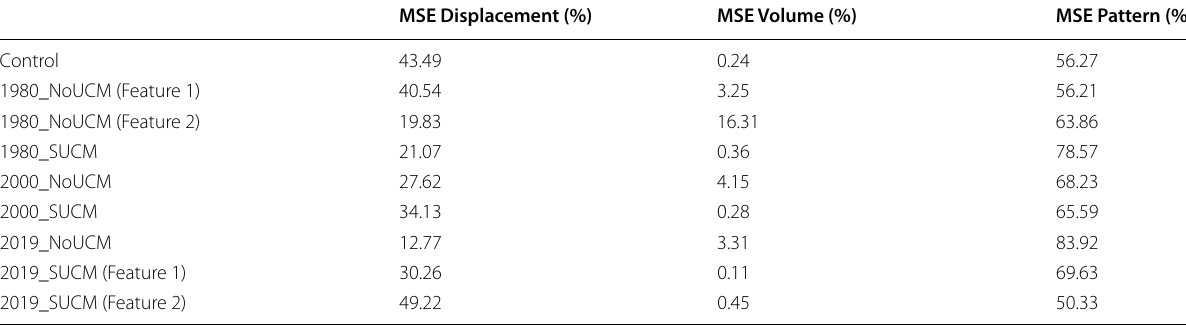
Table 2 Quantile representation of error decomposition from CRA